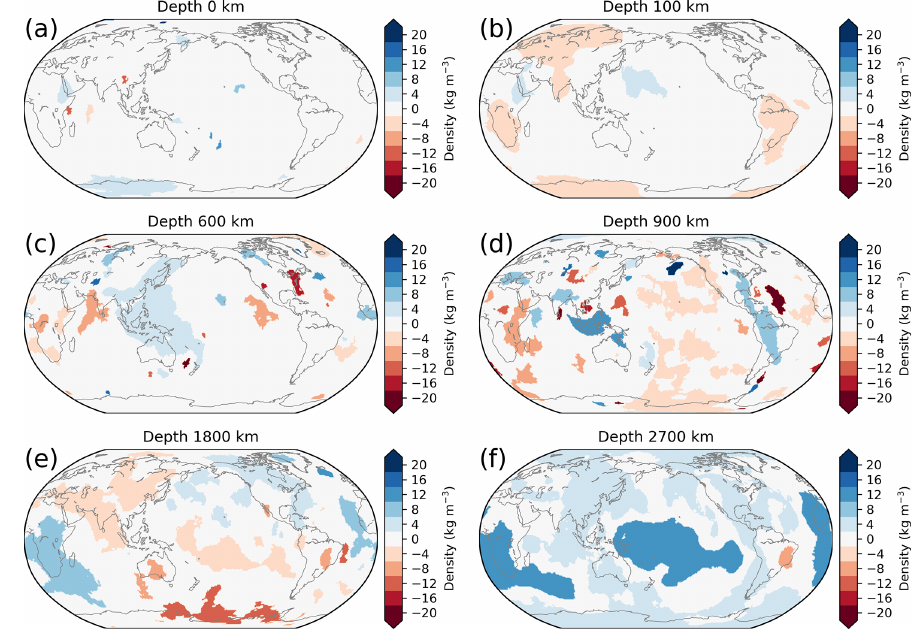
Figure 5. Density anomaly slices through selected depths of the inversion results using the isostatic